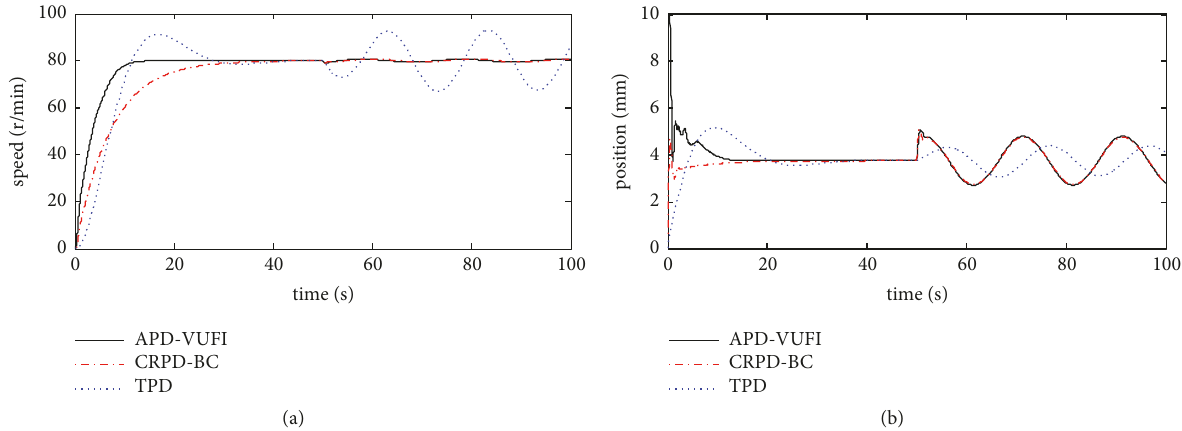
Figure 5: The comparison of speed regulation performances (a) and fuel index positions (b) by different controllers with a 50% model perturbation and sinusoidal wave disturbances after 50